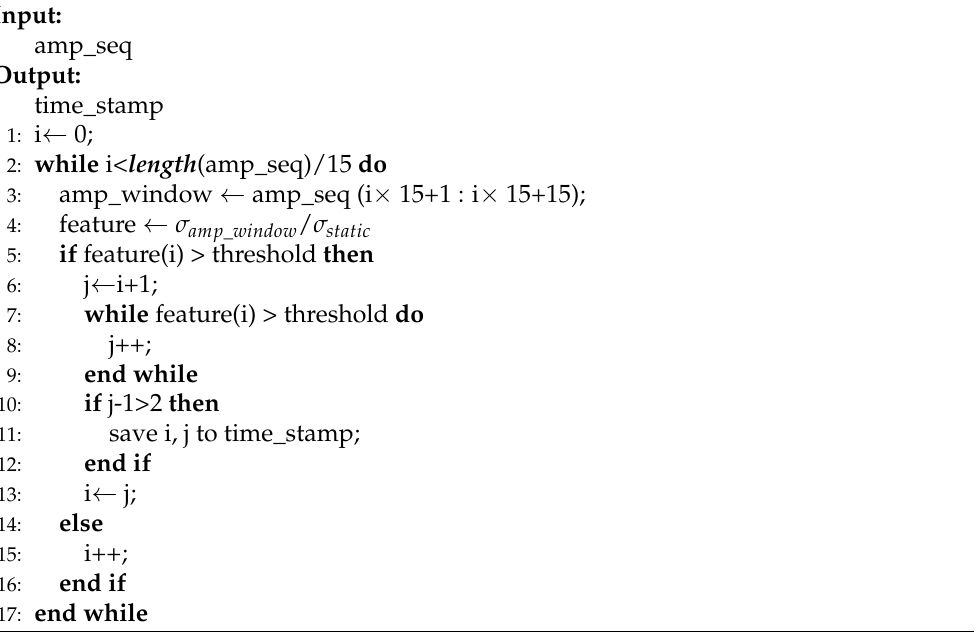
Figure 10. Sensing under LoS and nLoS condition: Fast (0.6 m/s) and Slow (0.3 m/s). ( a ) Fast passage of targets under nLoS. ( b ) Slow passage of targets under nLoS. ( c ) Fast passage of targets under nLoS. ( d ) Slow passage of targets under nLoS. Algorithm 3 Anomaly